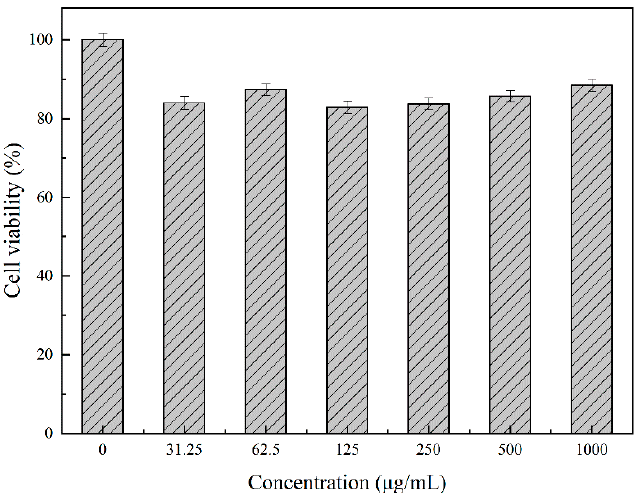
Figure 6. Detection of DF-1 cytotoxicity at different concentrations of NDV/SiO 2 @CMCS- N -2-